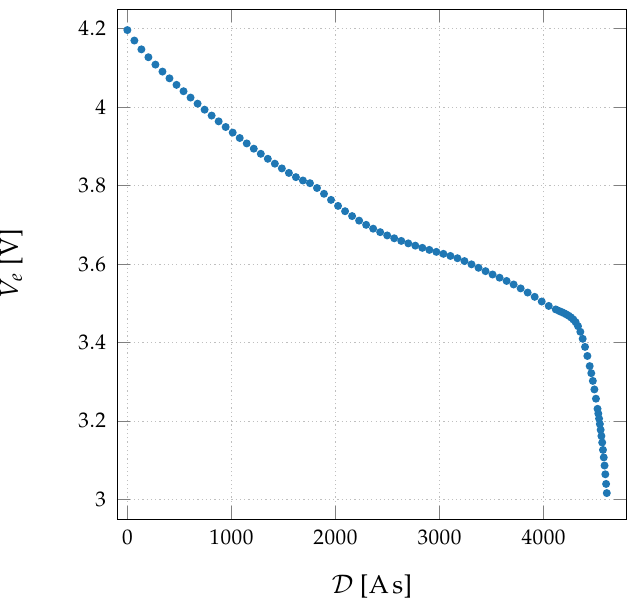
Figure 6. V e measured during the discrete identification method according to the drained charge